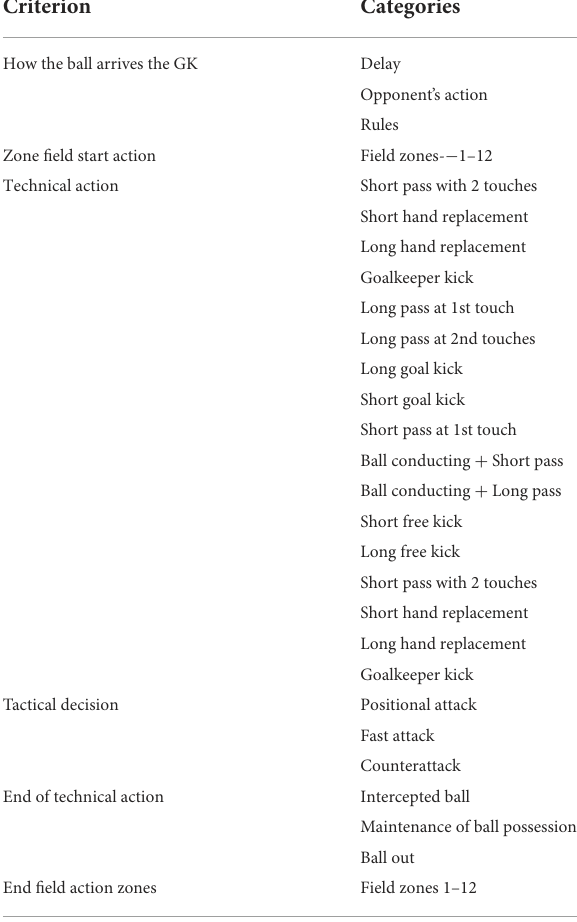
TABLE 2 Observational system of offensive technical-tactical